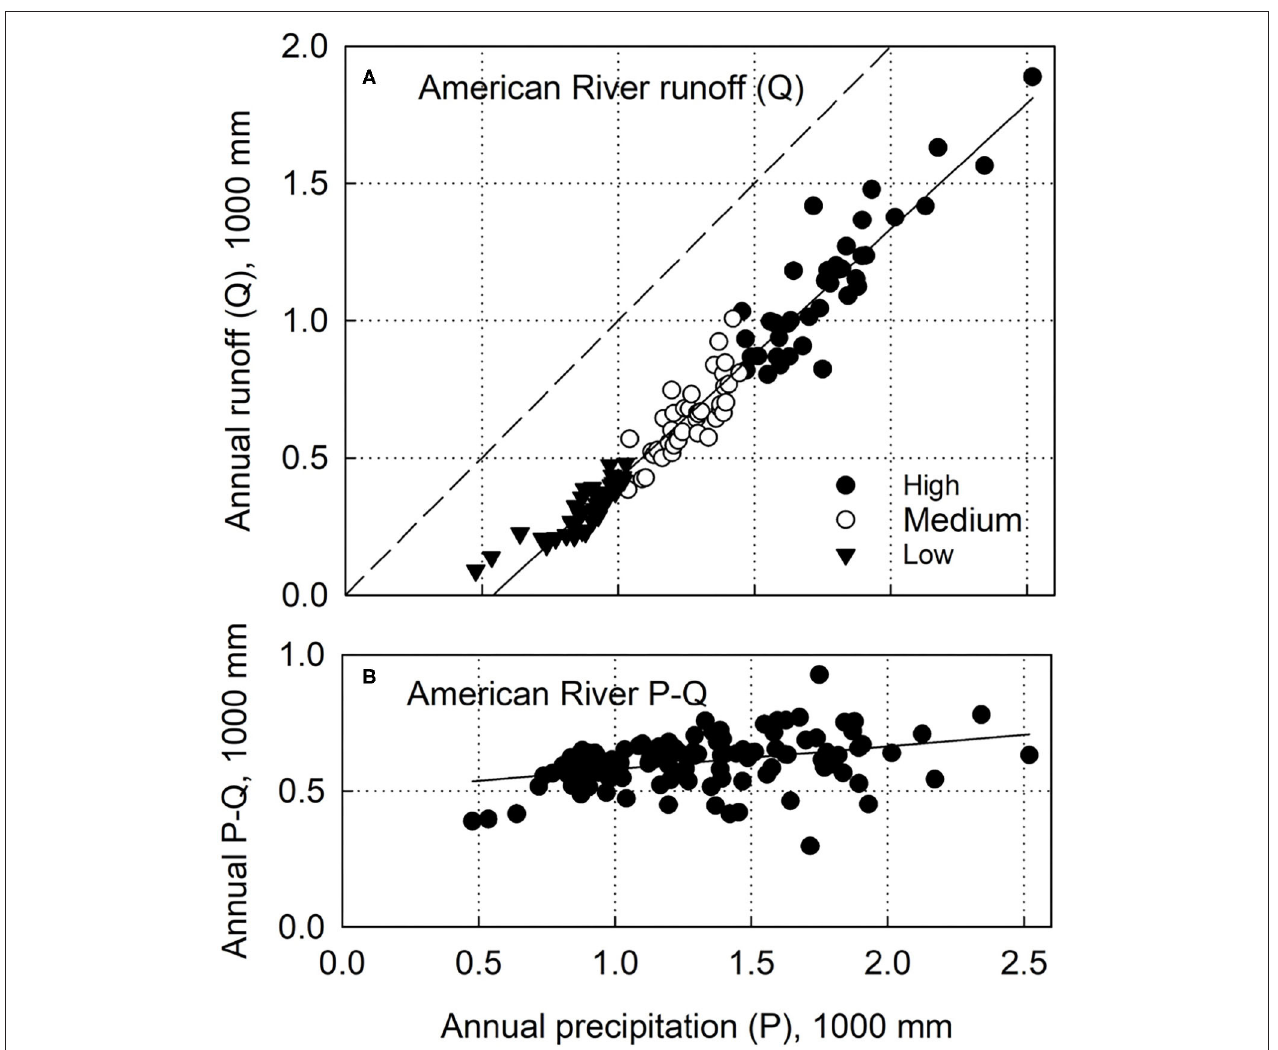
FIGURE 2 | Historical water-year (A) runoff and (B) precipitation minus discharge vs. annual precipitation for American River basin, 1901–2018. Runoff is full-natural flow, the calculated runoff that would occur in the absence of human influences (dams, diversions); data from California Department of Water Resources (http://cdec. water.ca.gov/), accessed Nov 27, 2020. Data are plotted by terciles for low, medium and high precipitation years. Basin-average precipitation summed from 800-m PRISM product (http://www.prism.oregonstate.edu), for area above runoff measurement point below Folsom